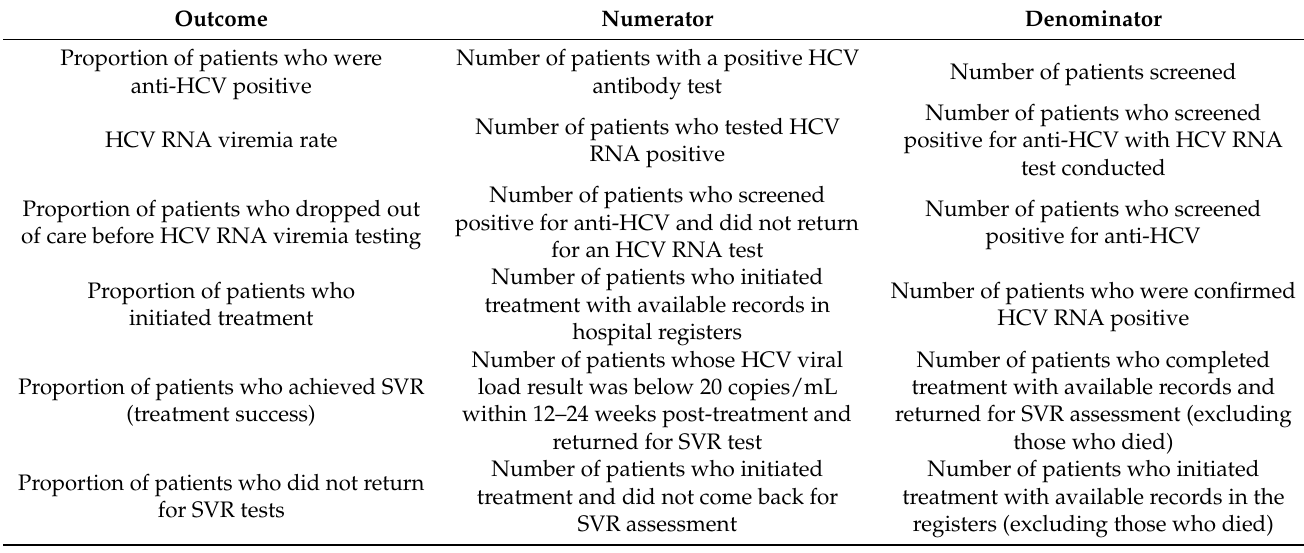
Table 1. Stages in the HCV cascade of